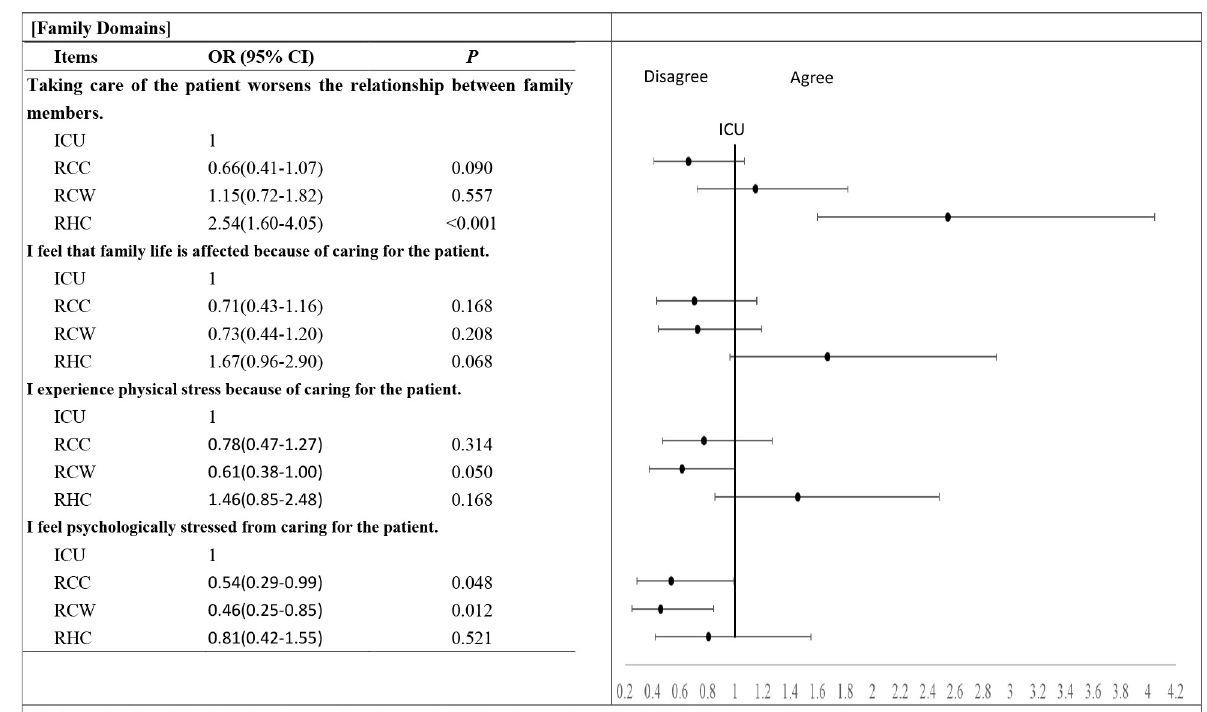
Fig 1. Odds of agreement in the life impact of the caregivers of PMV patients at various stages at family domain.